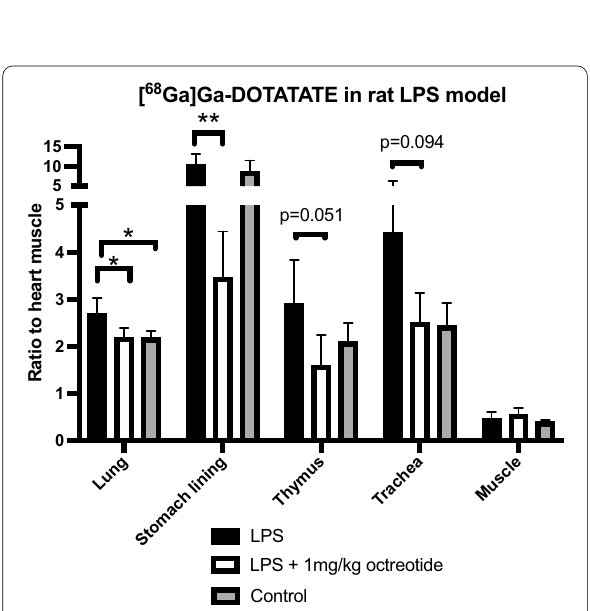
Fig. 3 Ex vivo biodistribution of lung, stomach, thymus, trachea and muscle [ 68 Ga]Ga‑DOTA‑TATE heart muscle ratio uptake on rats. First group was treated with LPS (black) and shows significant difference in lungs and stomach compared with second group treated with LPS together with blocking with octreotide (white). The LPS‑treated group also showed a significant difference compared with control group (grey) in the lungs, but not in stomach, thymus or trachea. The negative control tissue muscle had significantly lower uptake in the LPS group compared with lungs ( p < 0.0001), thymus ( p < 0.001) and trachea ( p <